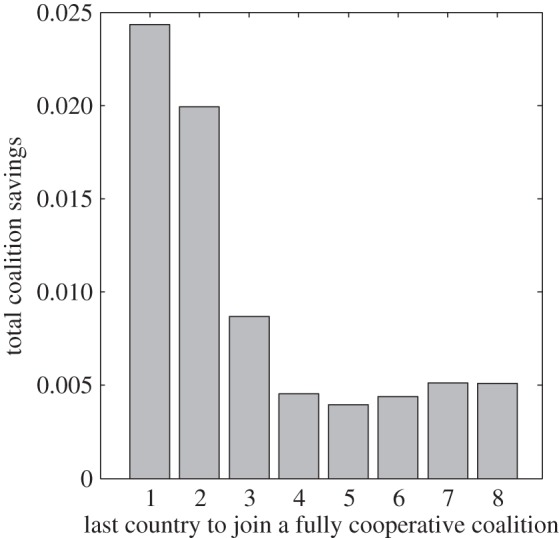
Overall coalition savings when a coalition becomes a fully cooperative coalition (all countries participate, k = n), with a country that joins the coalition last indicated on the x-axis. Parameter values as in figure 4.